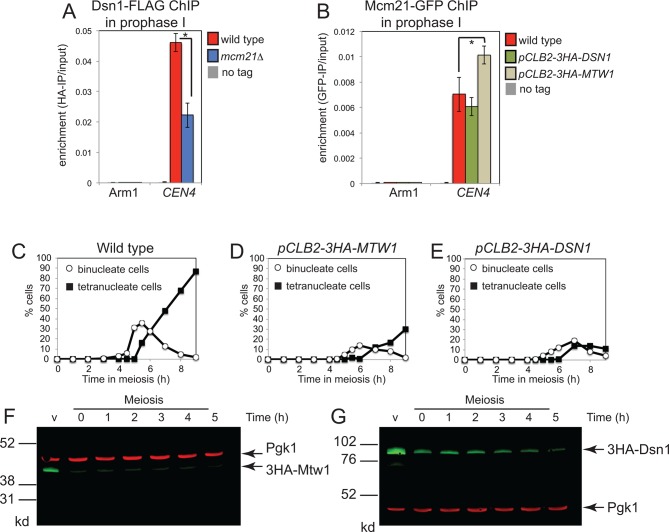
Partial inter-dependence of the Ctf19 complex and MIND subunits.(A) The Ctf19 component, Mcm21, is required for proper levels of Dsn1 at the centromere during prophase I. Strains AM11633 (no tag), AM20078 (DSN1-6HIS-3FLAG) and AM20080 (DSN1-6HIS-3FLAG mcm21△) all carrying ndt80△ were harvested 5 hr after resuspension in sporulation medium to induce a prophase I arrest and Dsn1 levels at CEN4 and a chromosomal arm site were measured by anti-FLAG ChIP-qPCR. (B) Effect of depleting the MIND components, Mcm21 or Dsn1, on centromeric levels of the Ctf19 component, Mcm21. Strains AM11633 (no tag), AM20296 (MCM21-yeGFP), AM20295 (MCM21-yeGFP pCLB2-3HA-DSN1), AM20294 (MCM21-yeGFP pCLB2-3HA-MTW1) all carrying ndt80△ were treated as in (A) except that anti-GFP ChIP-qPCR was performed. In (A) and (B) the mean of four biological replicates is shown with error bars indicating standard error. p values were obtained using a paired t test. * p<0.05. (C–G) Nuclear division and efficiency of protein depletion in pCLB2-3HA-MTW1 and pCLB2-3HA-DSN1 strains. Wild type (AM1835), pCLB2-3HA-MTW1 (AM20084) and pCLB2-3HA-DSN1 (AM20082) strains were induced to sporulate and the percentages of binucleate and tetranucleate cells were determined after scoring 100 cells at each of the indicated times (C–E). (F, G) The amount of 3HA-Dsn1 (F) or 3HA-Mtw1 (G) was analysed by anti-HA western immunoblot at the indicated times. Pgk1 is shown as a loading control. ChIP, Chromatin immunoprecipitation; MIND, Mtw1 including Nnf1-Nsl1-Dsn1; qPCR, quantitative polymerase chain reactionDOI: